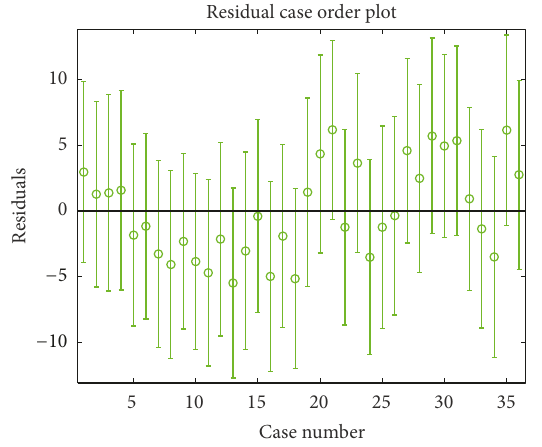
Figure 8: The analysis of